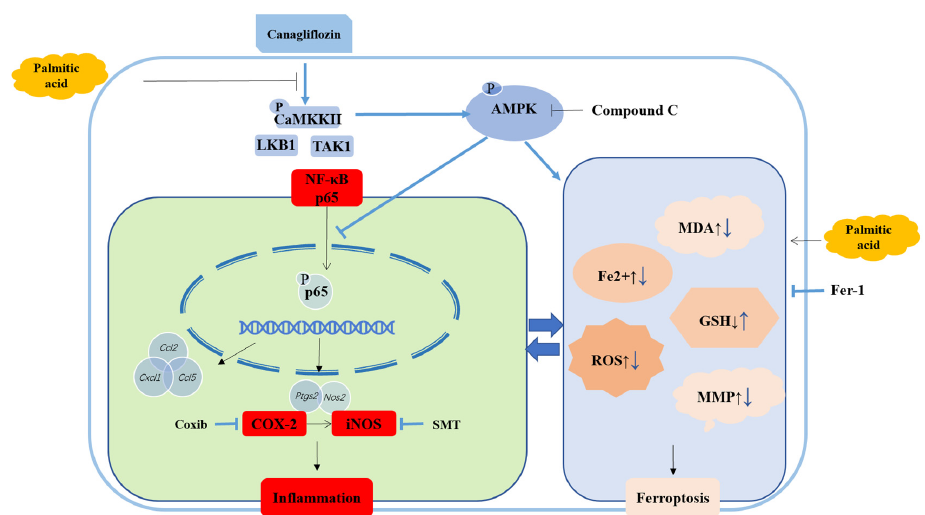
Figure 8. Schematic depicting that CAN attenuates lipotoxicity in cardiomyocytes by regulating p-p65/COX-2/iNOS-mediated inflammation and ferroptosis through activating AMPK pathway. Compound C, AMPK inhibitor; Coxib, COX-2 inhibitor; SMT, iNOS inhibitor; Fer-1, ferroptosis inhibitor.